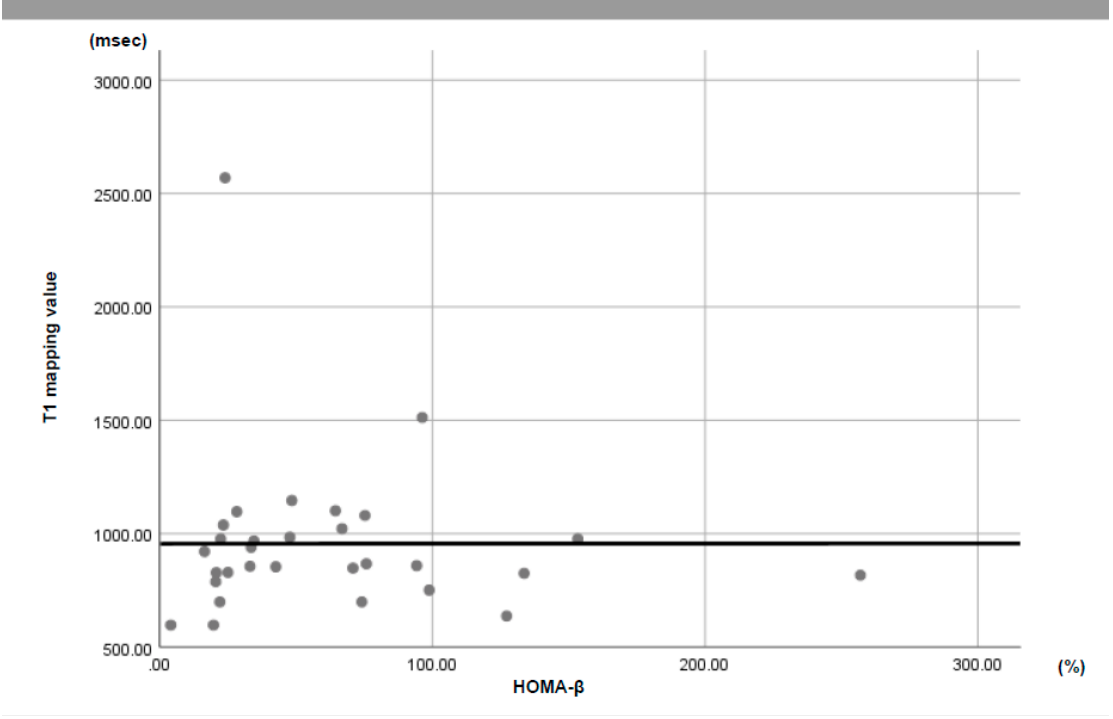
Figure 2. No remarkable correlation was observed between the T1 mapping values and HOMA- β ( r = − 0.094, R 2 = 0.001, p = 0.636). Table 1. Patient characteristics.